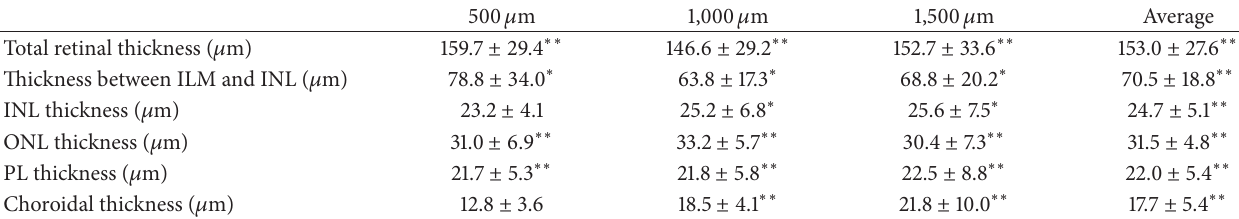
Table 2: The mean retinal and choroidal thicknesses in the SDT rats. Each value is based on the distance from the optic nerve disc (500, 1,000, and 1,500 𝜇 m). The average of the three values is calculated.